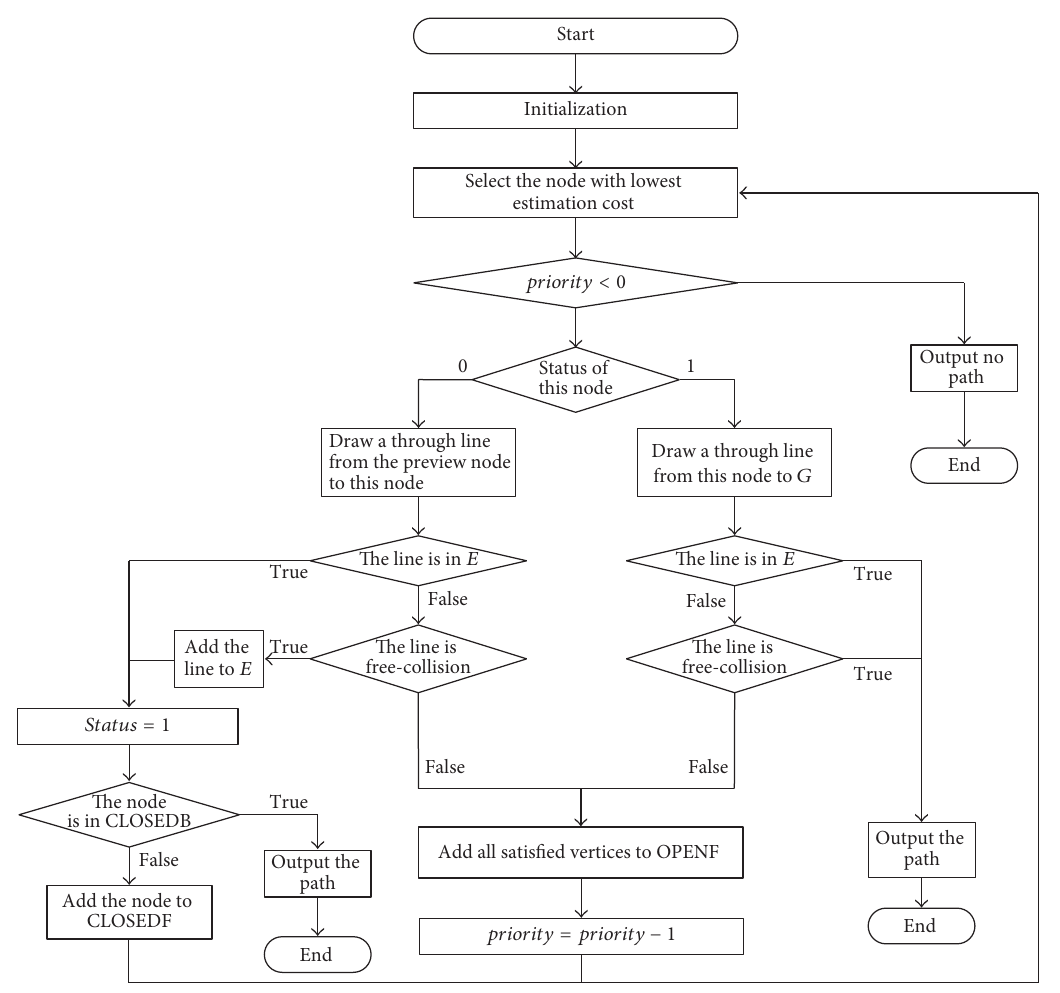
Figure 3: Forward